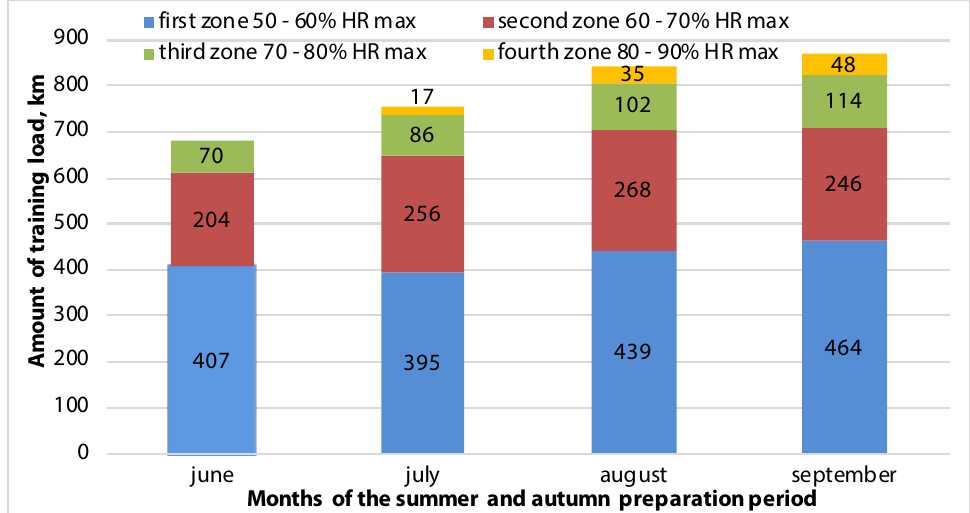
Figure 2. Relative amount of cyclic exercise in different HR zones in the total amount of cyclic